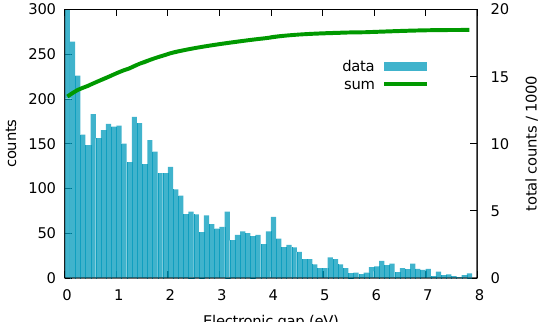
Fig. 3 Band gaps. Histogram of the electronic band-gap for all new stable compounds.